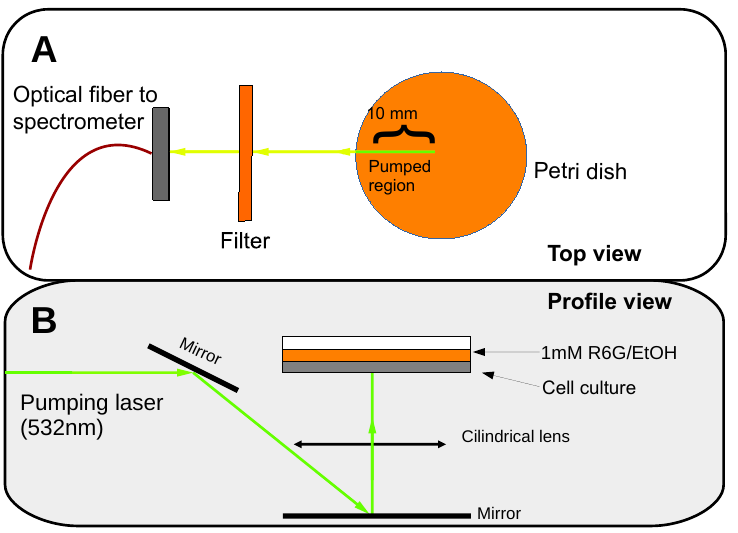
Figure 2. Experimental setup. ( A ) Top view of the experiment with the pumped region marked in green. ( B ) Profile view of the